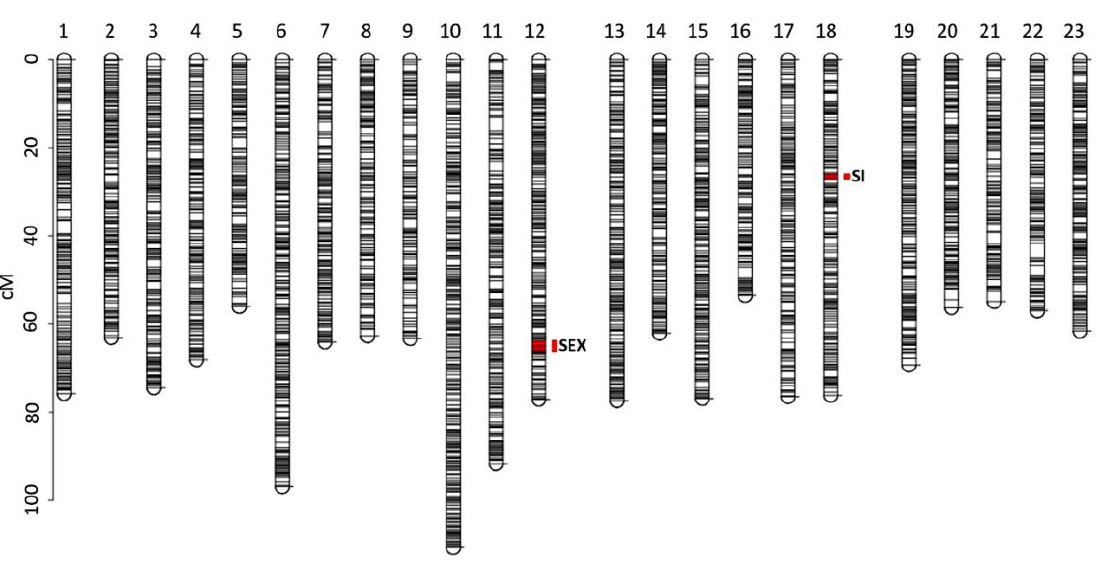
Figure 1. Phillyrea angustifolia sex-averaged linkage map showing the grouping and position of 15703 SNPs. The length of each of the 23 linkage groups is indicated by the vertical scale in cM. The markers strictly linked to sex and self-incompatibility (SI) phenotypes are shown in red. Markers that were